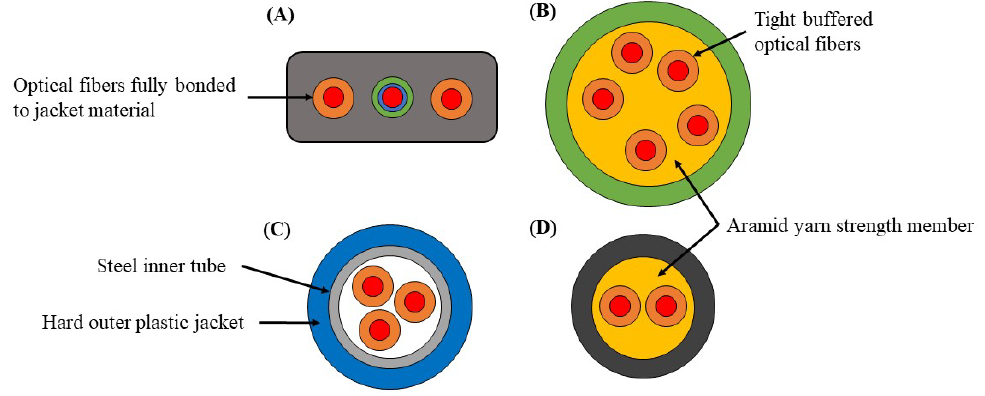
Figure 7. Fiber optic cables selected for comparison under various strain scenarios. ( A ) a strain sensing cable with optical fibers tightly secured to the jacket material (gray). ( B ) a strain sensing cable with optical fibers loosely packed in an aramid yard strength member (yellow) and not in contact with the jacket layer (green). ( C ) A strain sensing cable with a steel inner tube (gray) for additional protection, a hard outer plastic jacket (blue) and three interior tight buffered optical fibers. ( D ) a standard telecommunications cable with a plenum jacket (black) and aramid yarn strength member (yellow), similar in construction to ( B ).